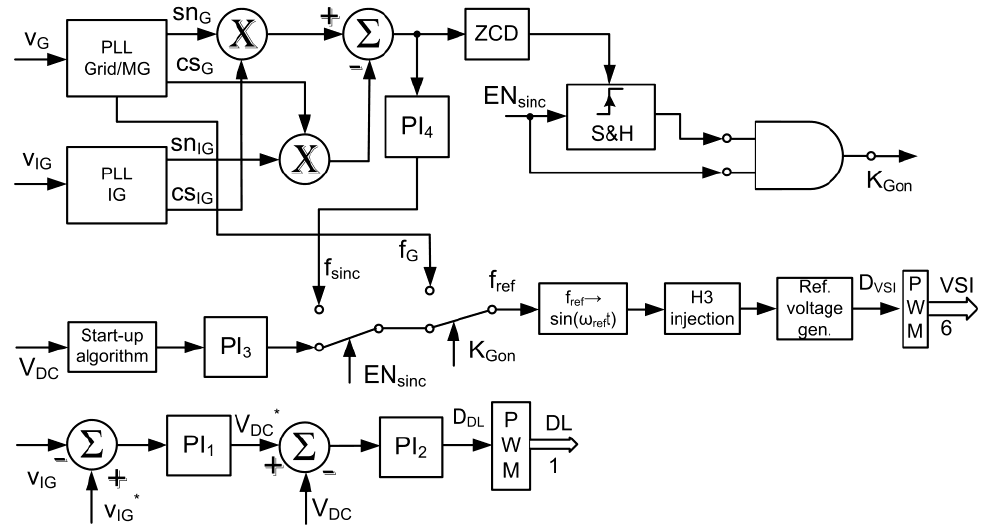
Figure 3. Block diagram of the IG system control.